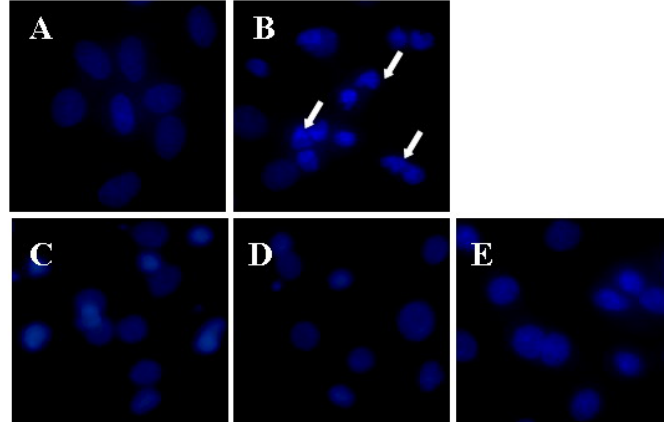
; ( C ) apigenin at 0.1; 25–35 (×400). 25–35